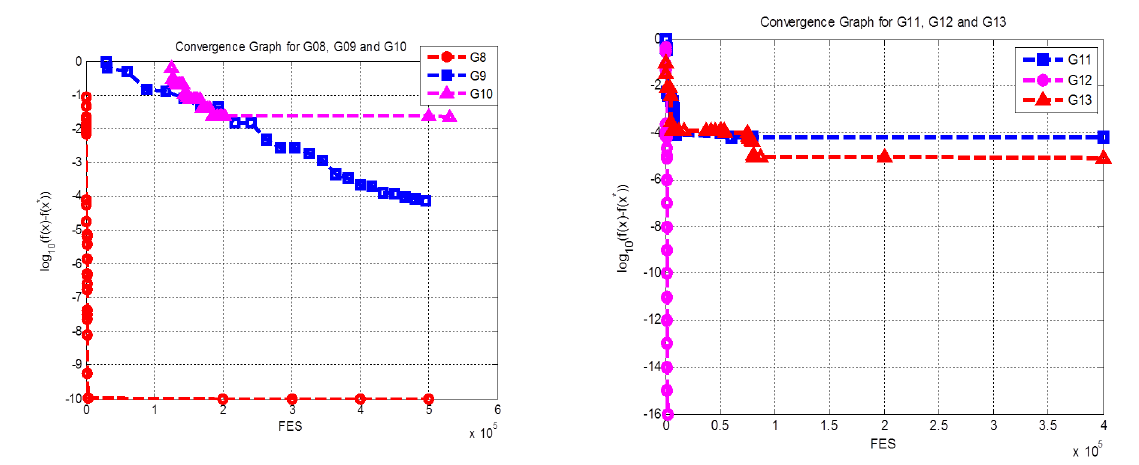
Figure 3. Convergence graph for G08 to G13.